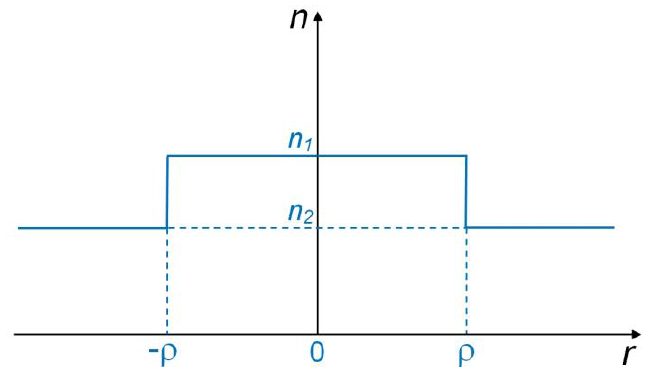
Figure 1. Index profile of an optical